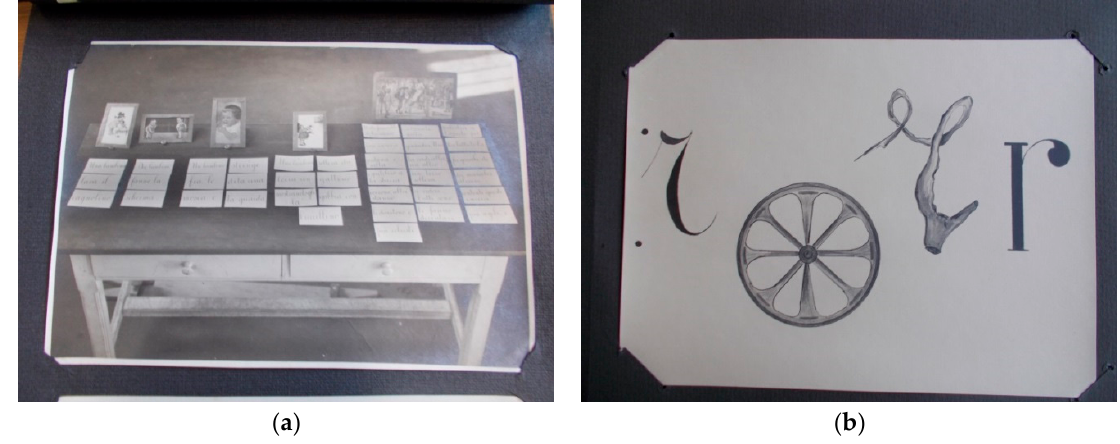
Figure 6. ( a , b ) Self-produced didactic aids from Padre Gemelli school (ASPG, file